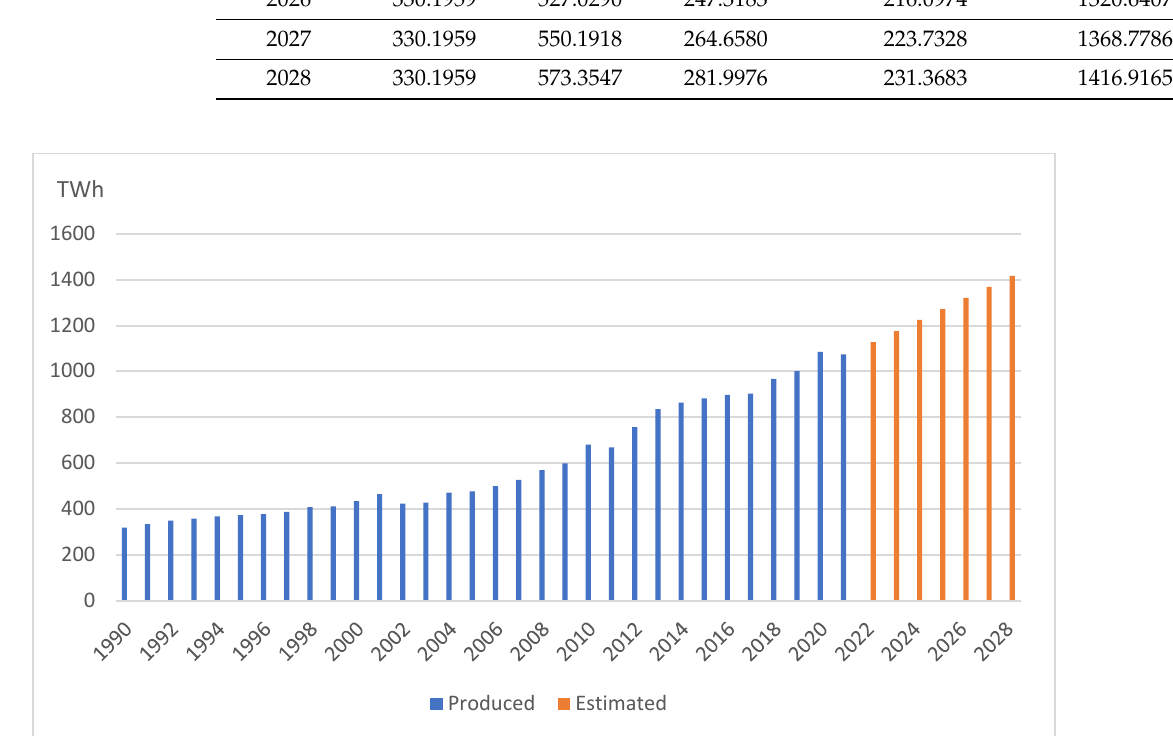
Figure 5. Renewable electricity forecast. Source: own elaborations.